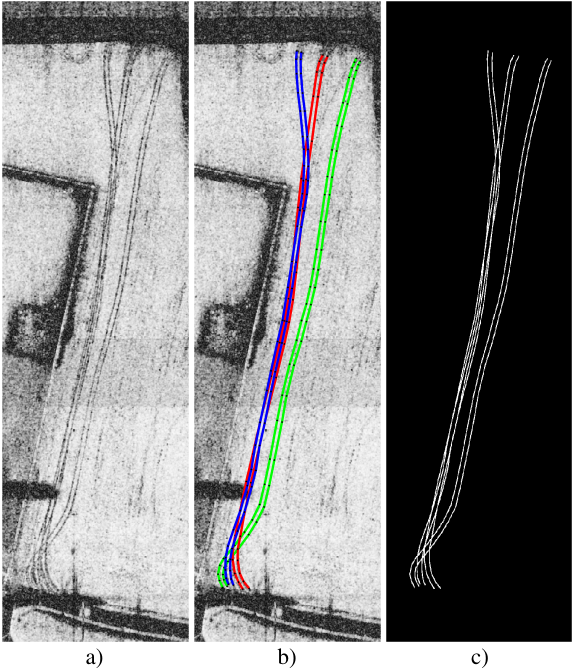
Figure 3. Manual track extraction for reference purposes (here Image C 1 ): a) coherence image; b) vector-based manual extraction; c) binary mask with dilated tracks.